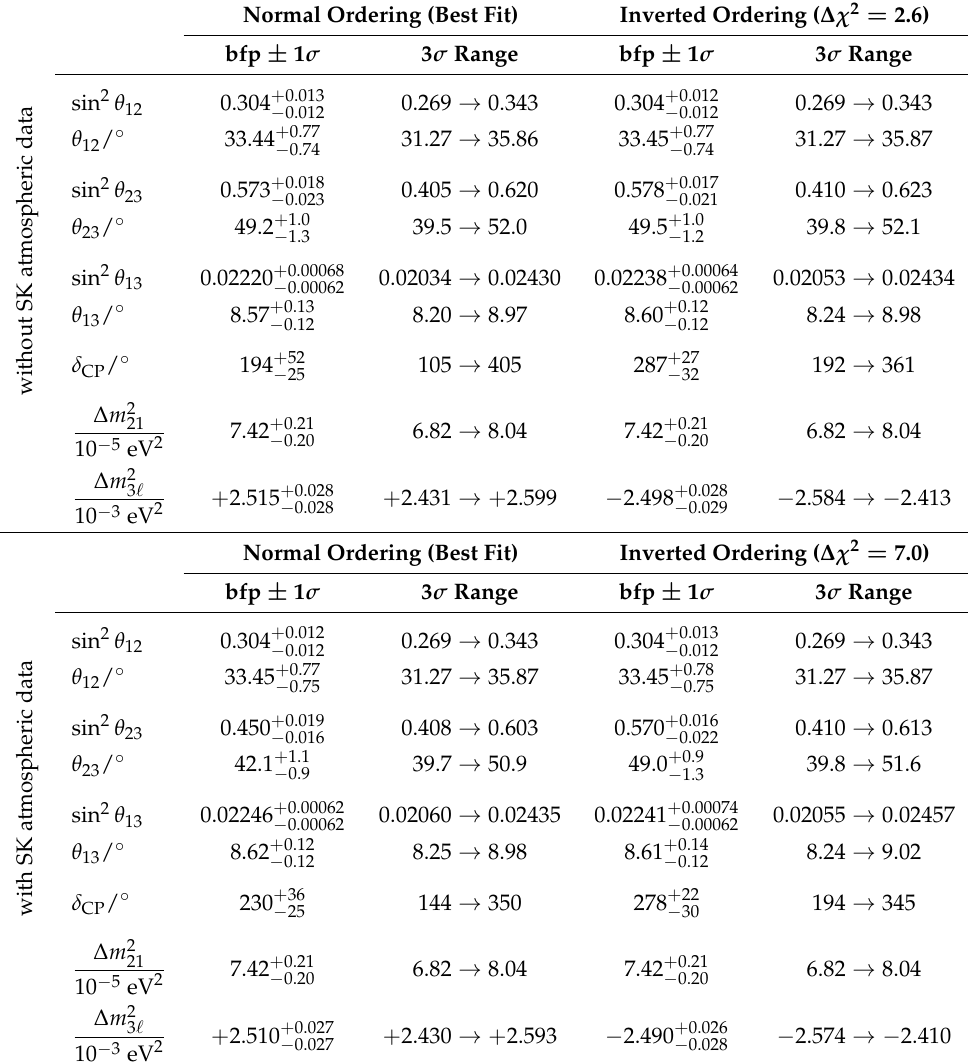
Table 2. Determination of three-flavour oscillation parameters from fit to global data NuFIT 5.1 [30,36]. Results in the first and second columns correspond to analysis performed under the assumption of NO and IO, respectively; therefore, they are confidence intervals defined relative to the respective local minimum. Results shown in the upper and lower sections correspond to analysis performed without and with the addition of tabulated SK-atm ∆ χ 2 data respectively. In quoting values for